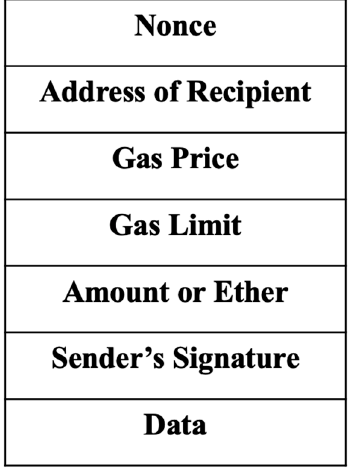
Figure 1. Structure of a Transaction.